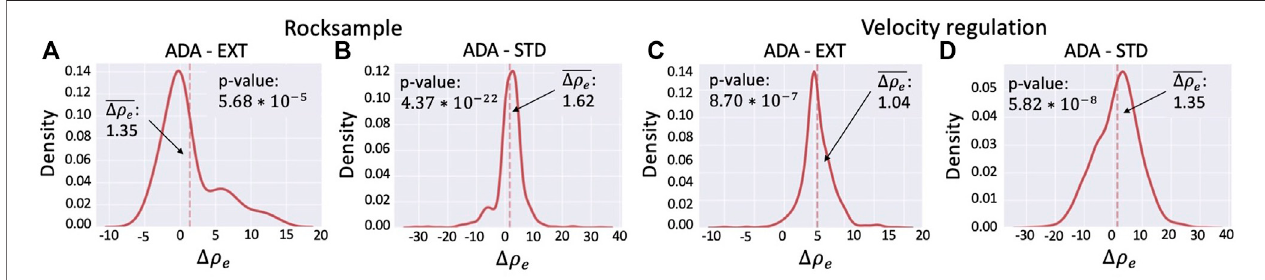
FIGURE 8 | Density of difference in discounted return between (A) ADA and EXT on rocksample. (B) ADA and STD on rocksample. (C) ADA and EXT on velocity regulation. (D) ADA and STD on velocity regulation.